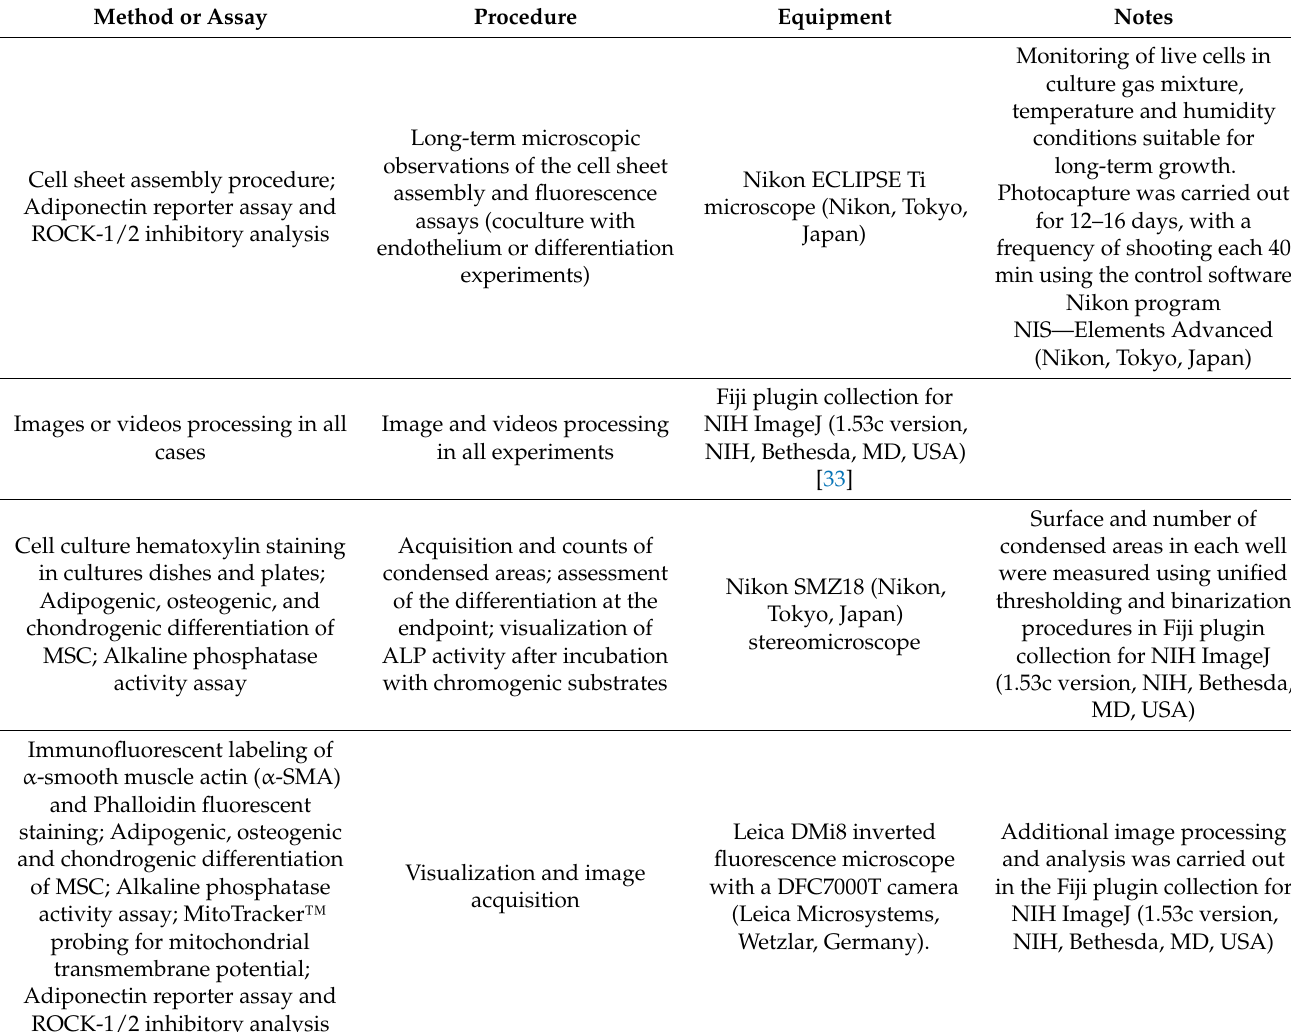
Table 1. Brief overview of the microscopy procedures and equipment used in the respective methods and assays. Method or